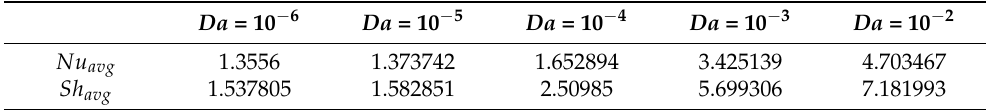
Table 5. Average Nu and Sh